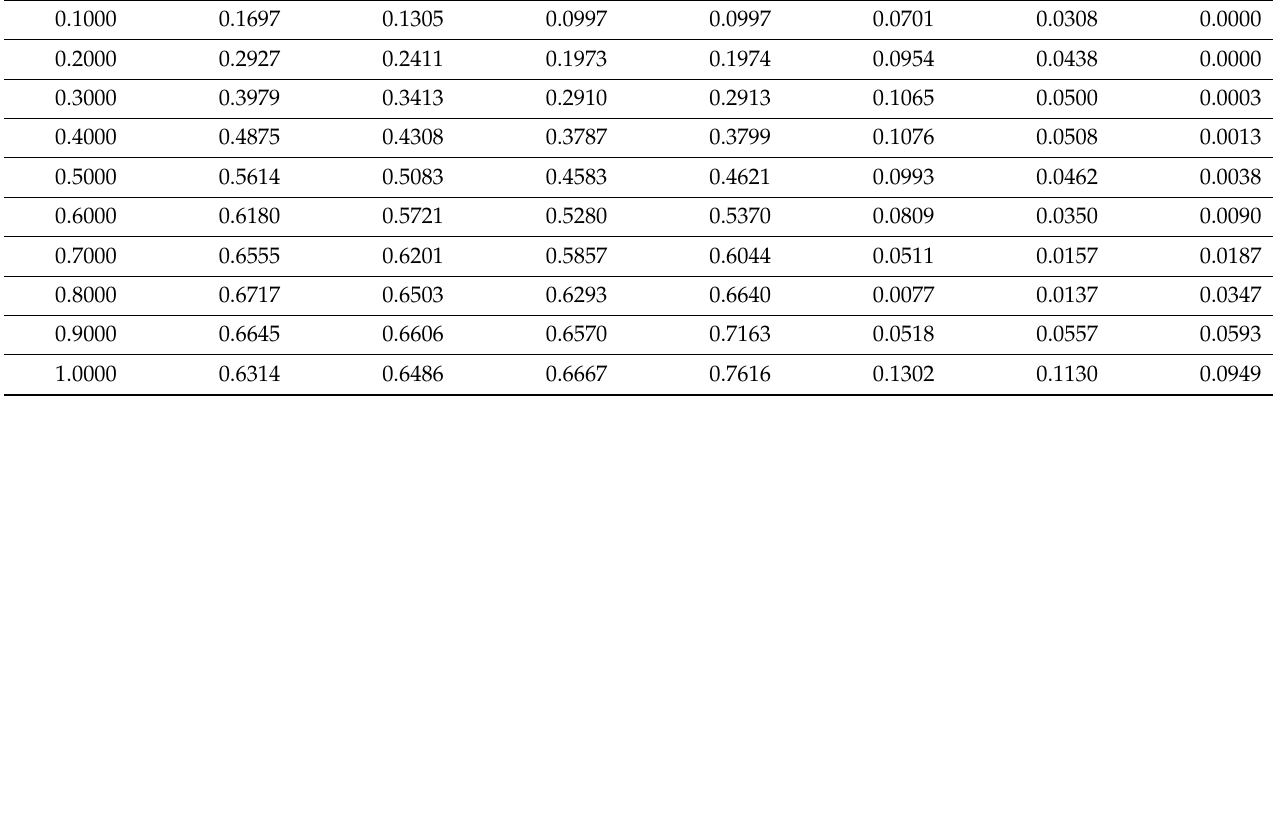
Table 1. Values of the approximate and exact solutions of Equation (19) at di ff erent values of 𝓉 . 𝒕 𝔂 𝝈(cid:2880)𝟎.𝟖